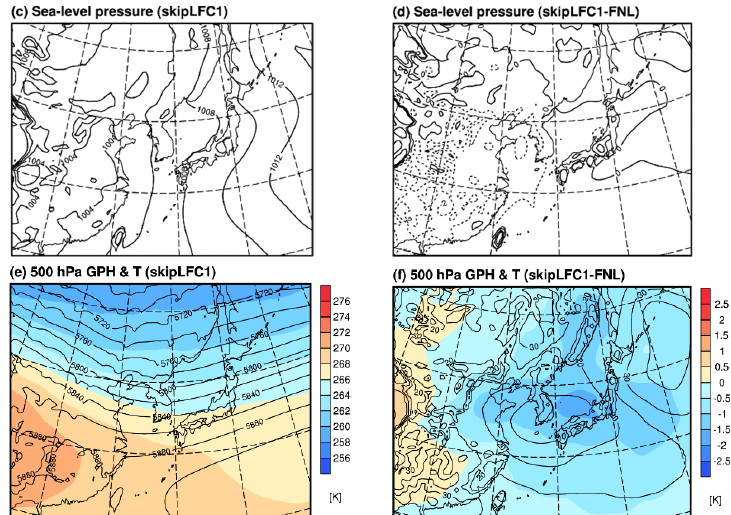
Figure 9. Spatial distribution of ( a ) precipitation (mm month − 1 ), ( c ) sea-level pressure (hPa), and ( e ) 500 hPa geopotential height (gmp; solid lines) and temperature (K; shading) over East Asia averaged for JJA 2006 from the skipLFC1 experiment. ( b , d , and f ) The difference between the skipLFC1 experiment and observations are shown in the right column. Contour interval is 1 hPa in ( d ), with negative contours dashed.